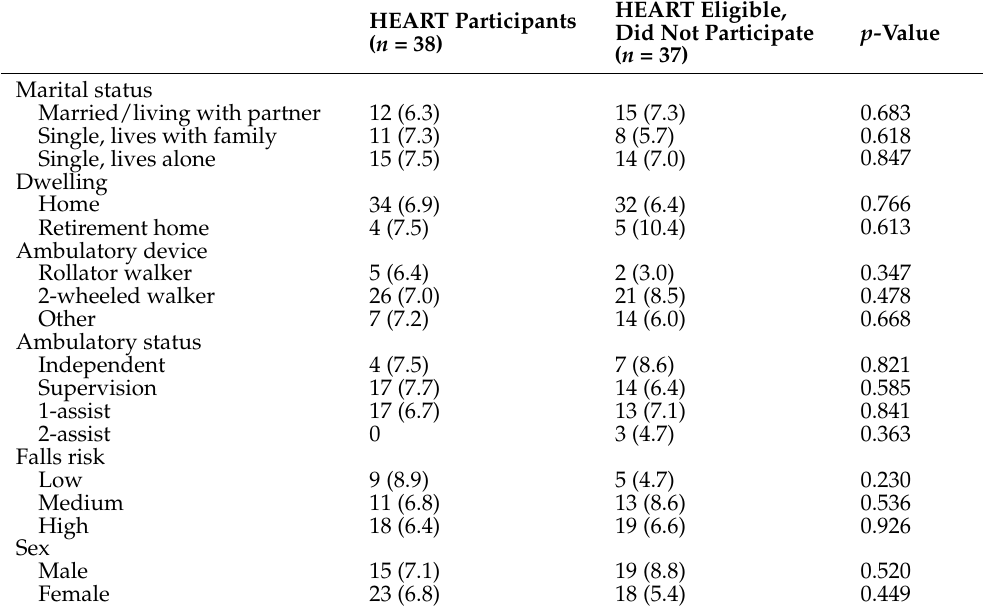
Table 3. Readmission to the hospital in HEART and non-HEART participants based on predictor variables, n